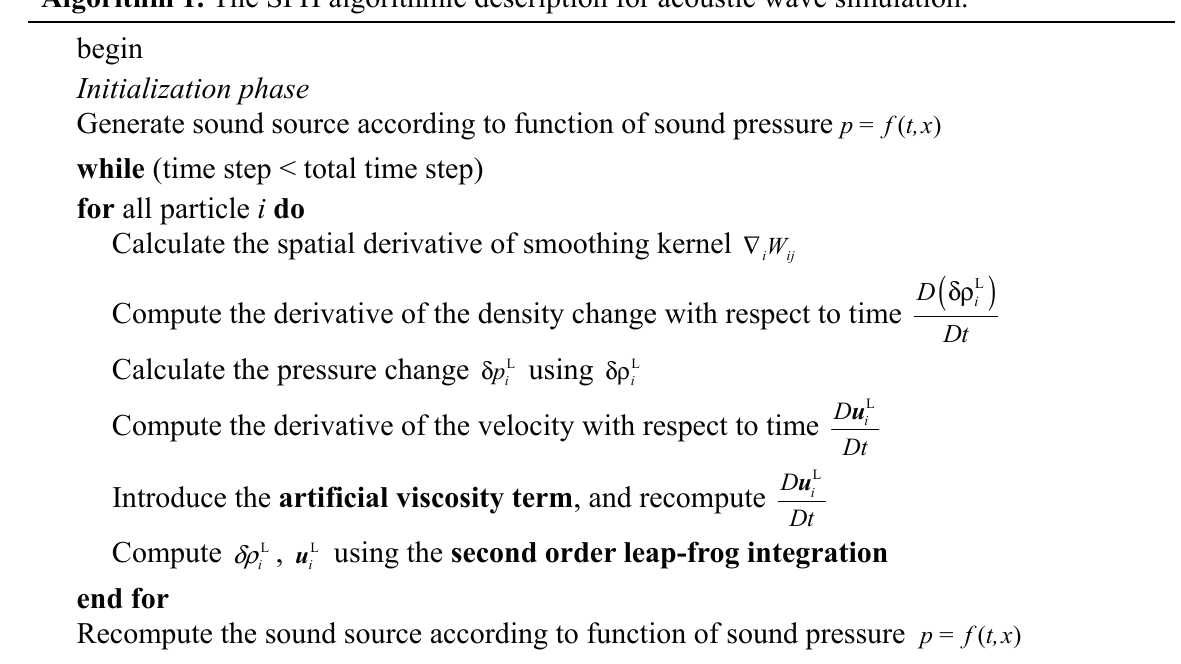
Algorithm 1. The SPH algorithmic description for acoustic wave